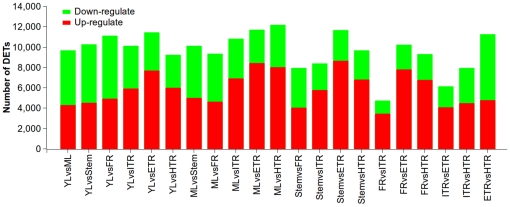
Transcripts differentially expressed between different tissues.Up-(red) and down-regulated (green) transcripts were quantified. The results of 21 comparisons between each two samples are shown.